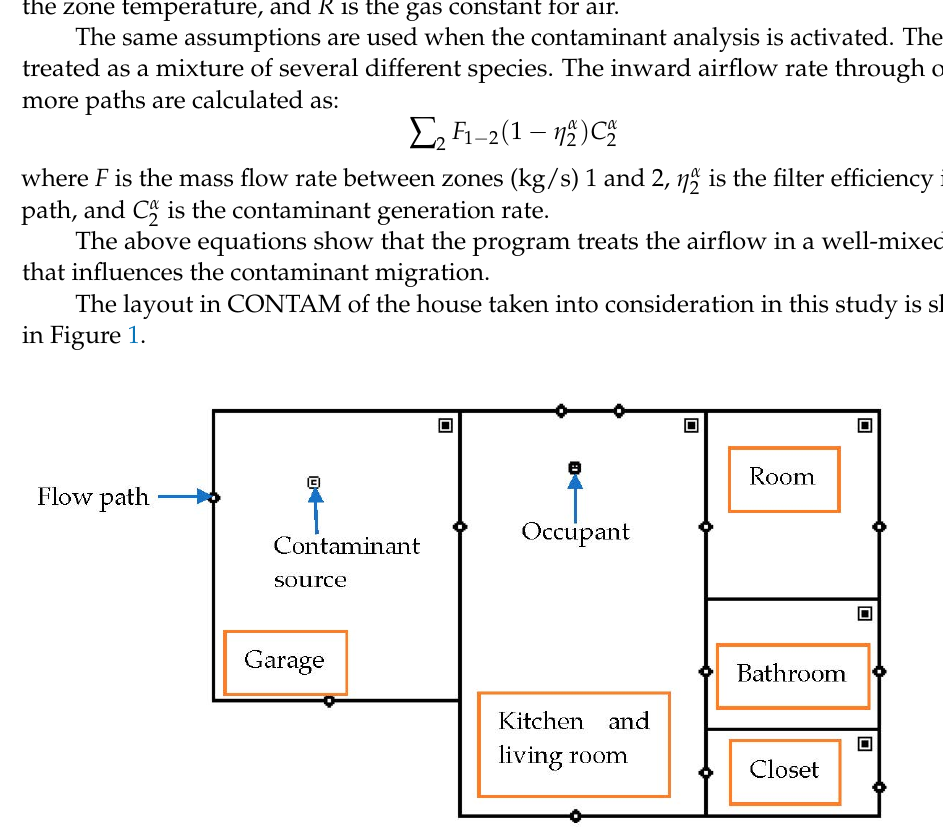
Figure 1. The layout of the house from the CONTAM application. Each zone has a dedicated name and flow paths. The infiltration and weather con- ditions were constant for all the simulations, as the aim was to see the influence of